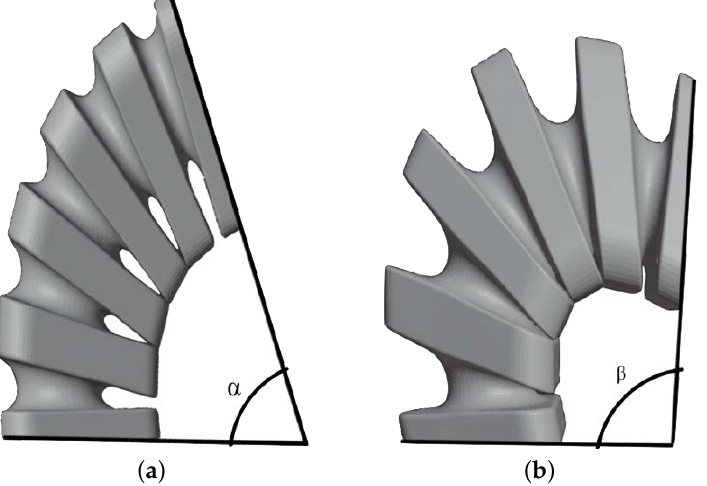
Figure 3. Different bending configurations. Relationship between bending angles: α < β . ( a ) Flexion in configuration 1 has the lowest maximum bending angle. ( b ) Flexion in configuration 2 has the higher maximum bending angle.